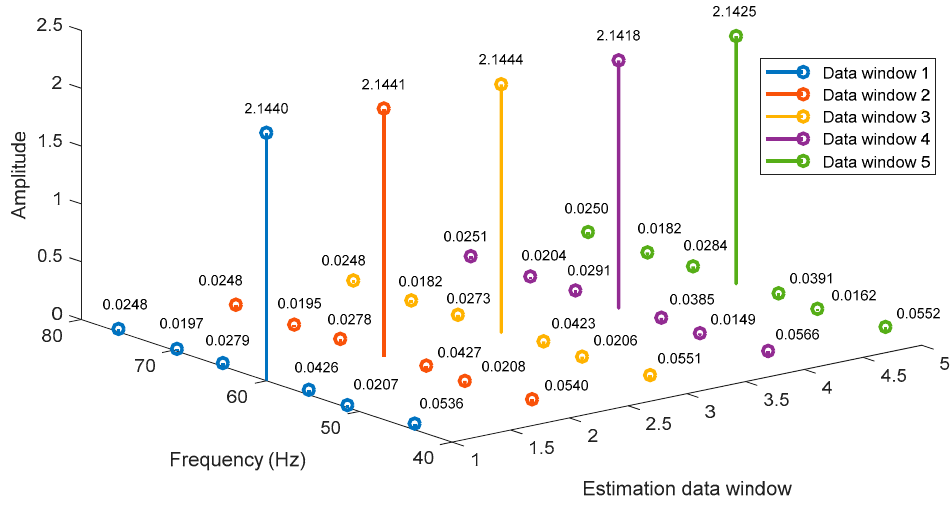
Figure 18. Prony estimated frequency spectrum at 60 Hz frequency speed operation scenario.